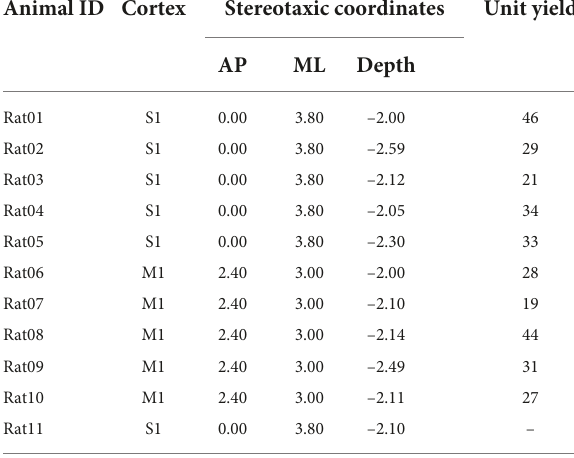
TABLE 1 Targeted cortex, corresponding stereotaxic coordinates of the first shank, and unit yields of animal used in this study. Animal ID